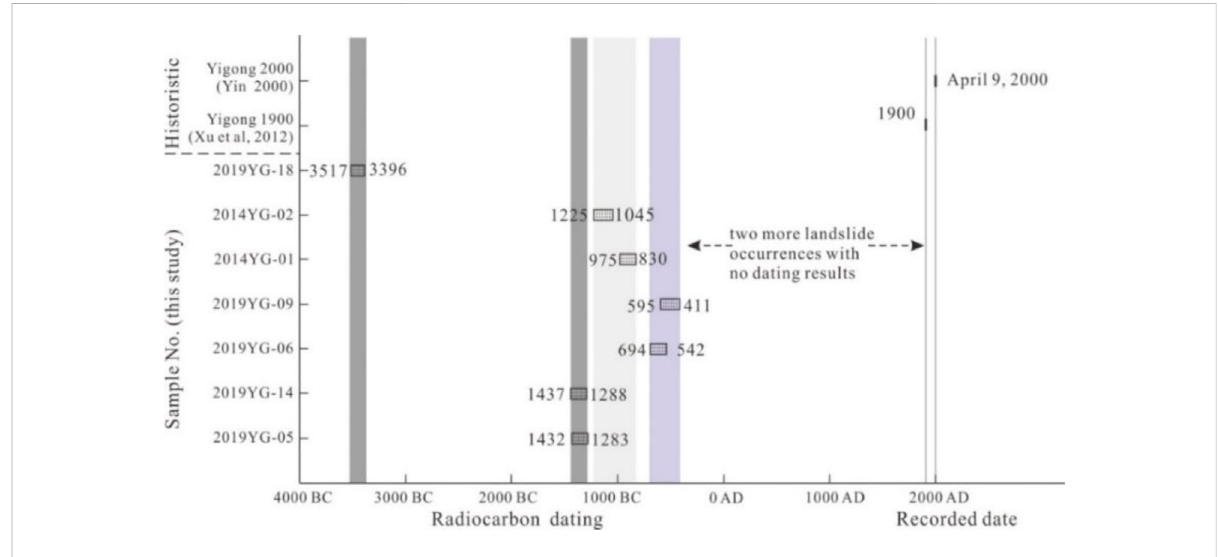
FIGURE 12 Age ranges dating the different landslides at the Yigong location (after Guo et al., 2000).